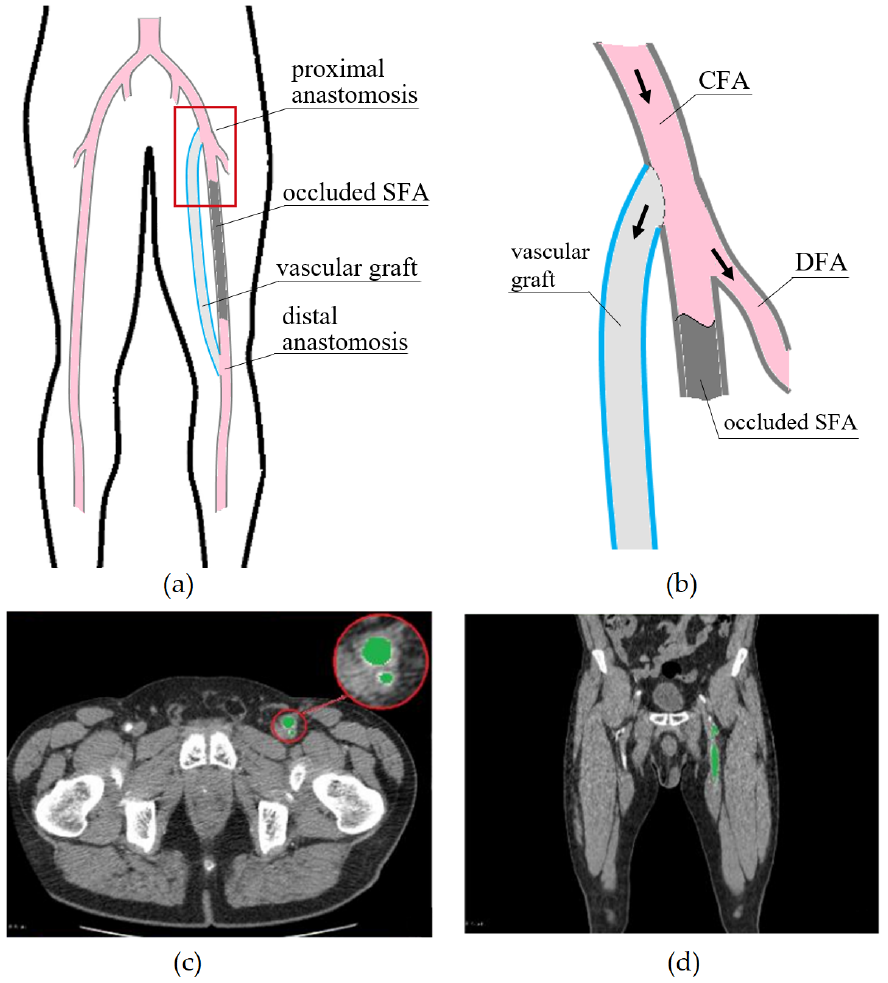
Figure 1. ( a ) Scheme of femoral-popliteal bypass. ( b ) Scheme of blood flow in proximal anastomosis. Examples of ( c ) cross and ( d ) longitudinal images by multispiral computed tomography. Arrows indicate the blood flow direction. Table 1. Parameters of the considered